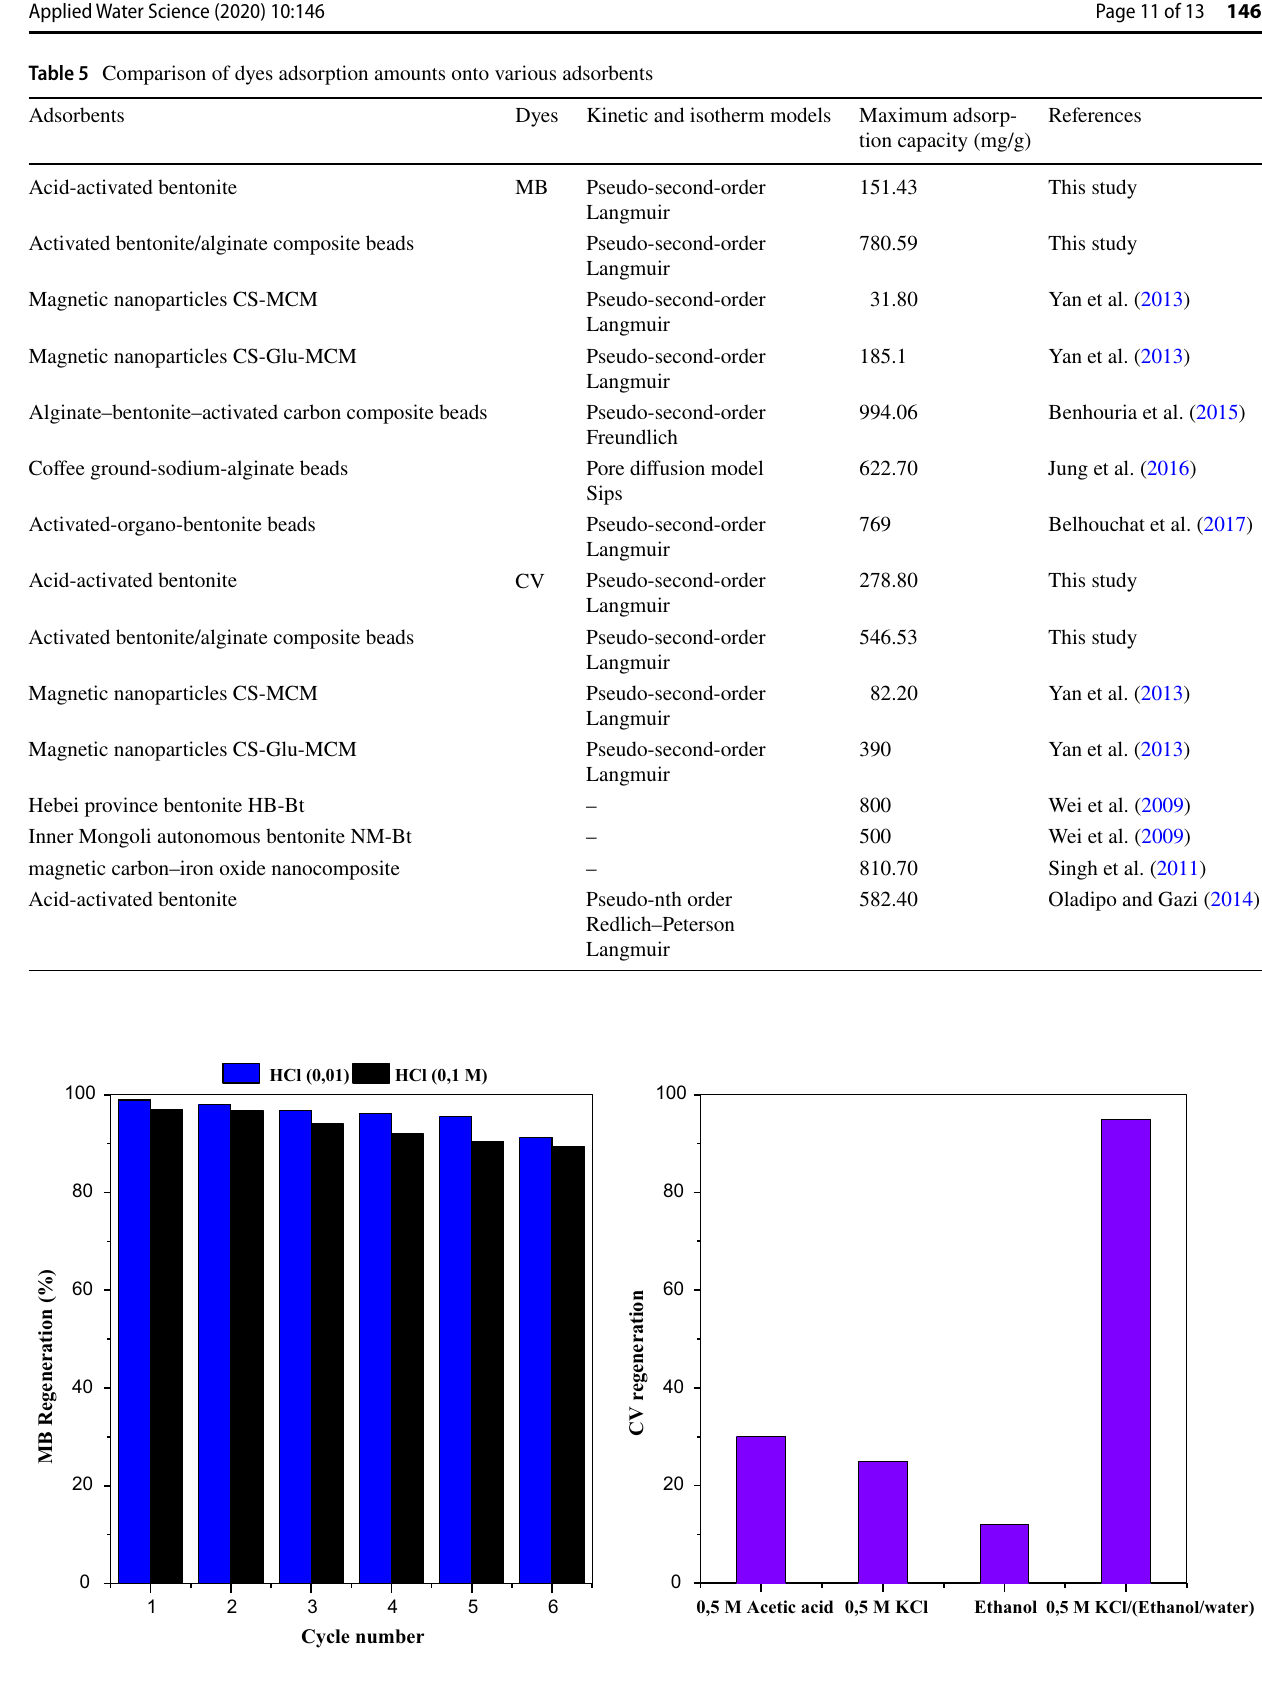
Fig. 10 Methylene blue and crystal violet